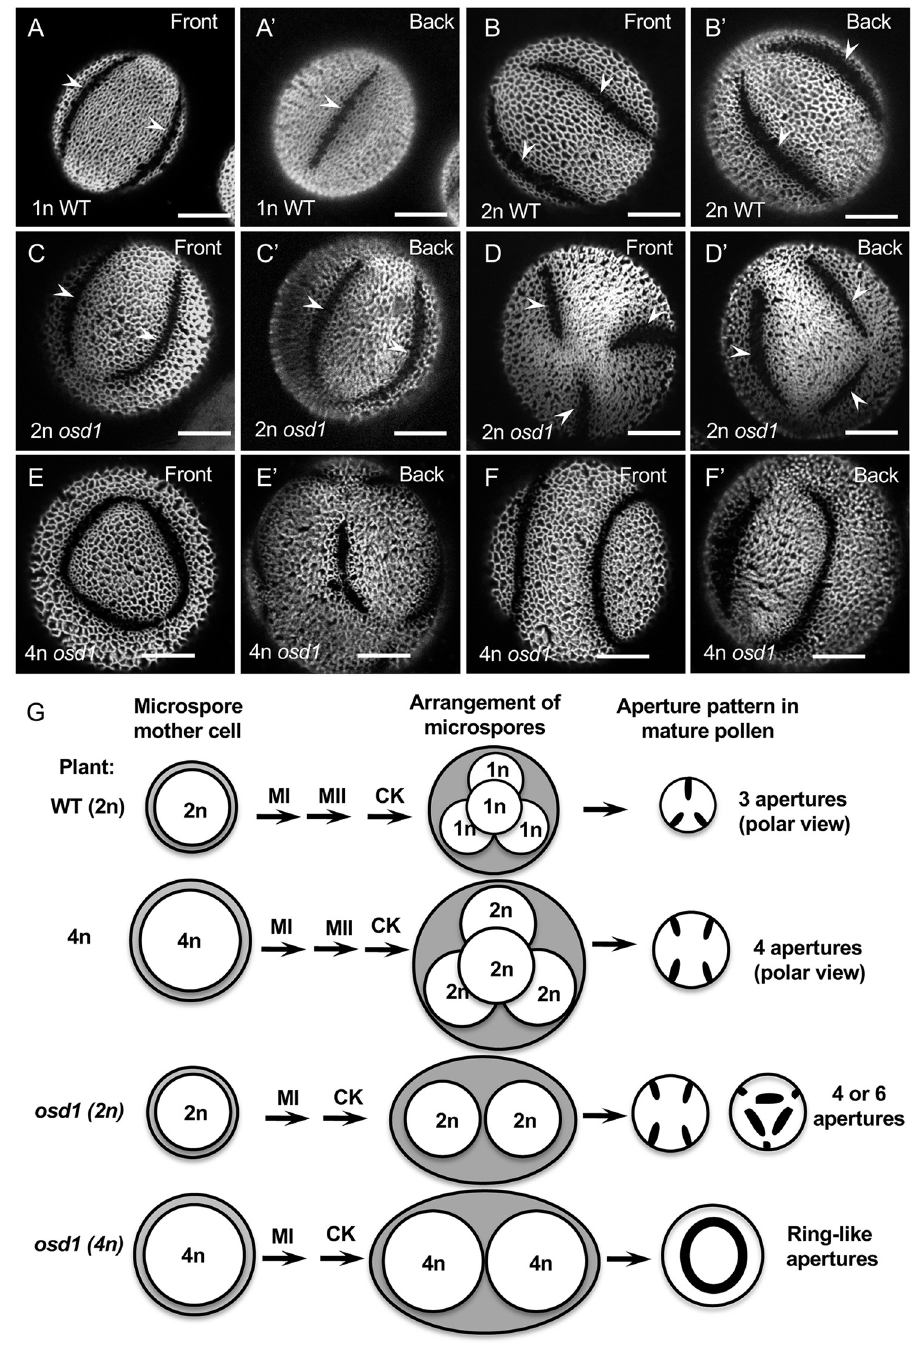
Fig 1. Changes in pollen ploidy and size correlate with changes in aperture number. (A-A’) Haploid pollen of wild- type Arabidopsis (Landsberg erecta ecotype) have three apertures (arrowheads). Front and back views of the auramine O-stained pollen grains are shown here and in other images as indicated. (B-B’) Diploid Landsberg pollen grains from tetraploid plants are larger than haploid pollen grains and have primarily four apertures (arrowheads). (C-D’) Diploid pollen grains from a diploid osd1 mutant usually have either four (C-C’) or six (D-D’) apertures (arrowheads). (E-F’) Irregular aperture patterns, often adopting a ring-shaped morphology, are common among tetraploid pollen grains from the tetraploid osd1 mutants. (G) A diagram of pollen development and aperture formation in the wild-type Arabidopsis and in several mutants with abnormal pollen ploidy. The ploidy of microspore mother cells (MMC), which divide meiotically to generate microspores, is the same as in the plants producing these MMCs. In the